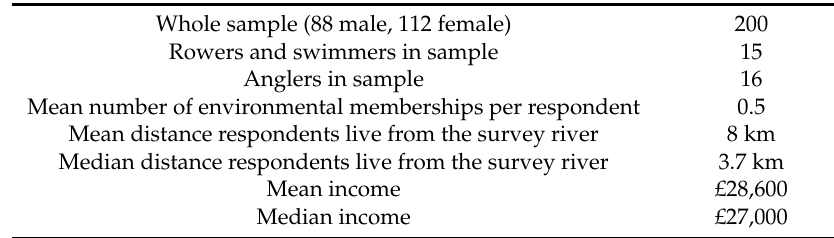
Table 1. Descriptive